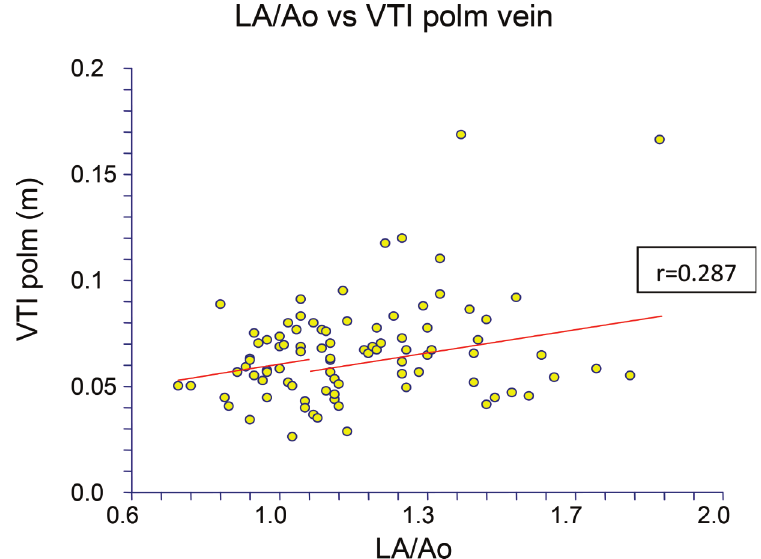
Figure 3 - Relationship between pvVTI and LA/Ao on day 4 of